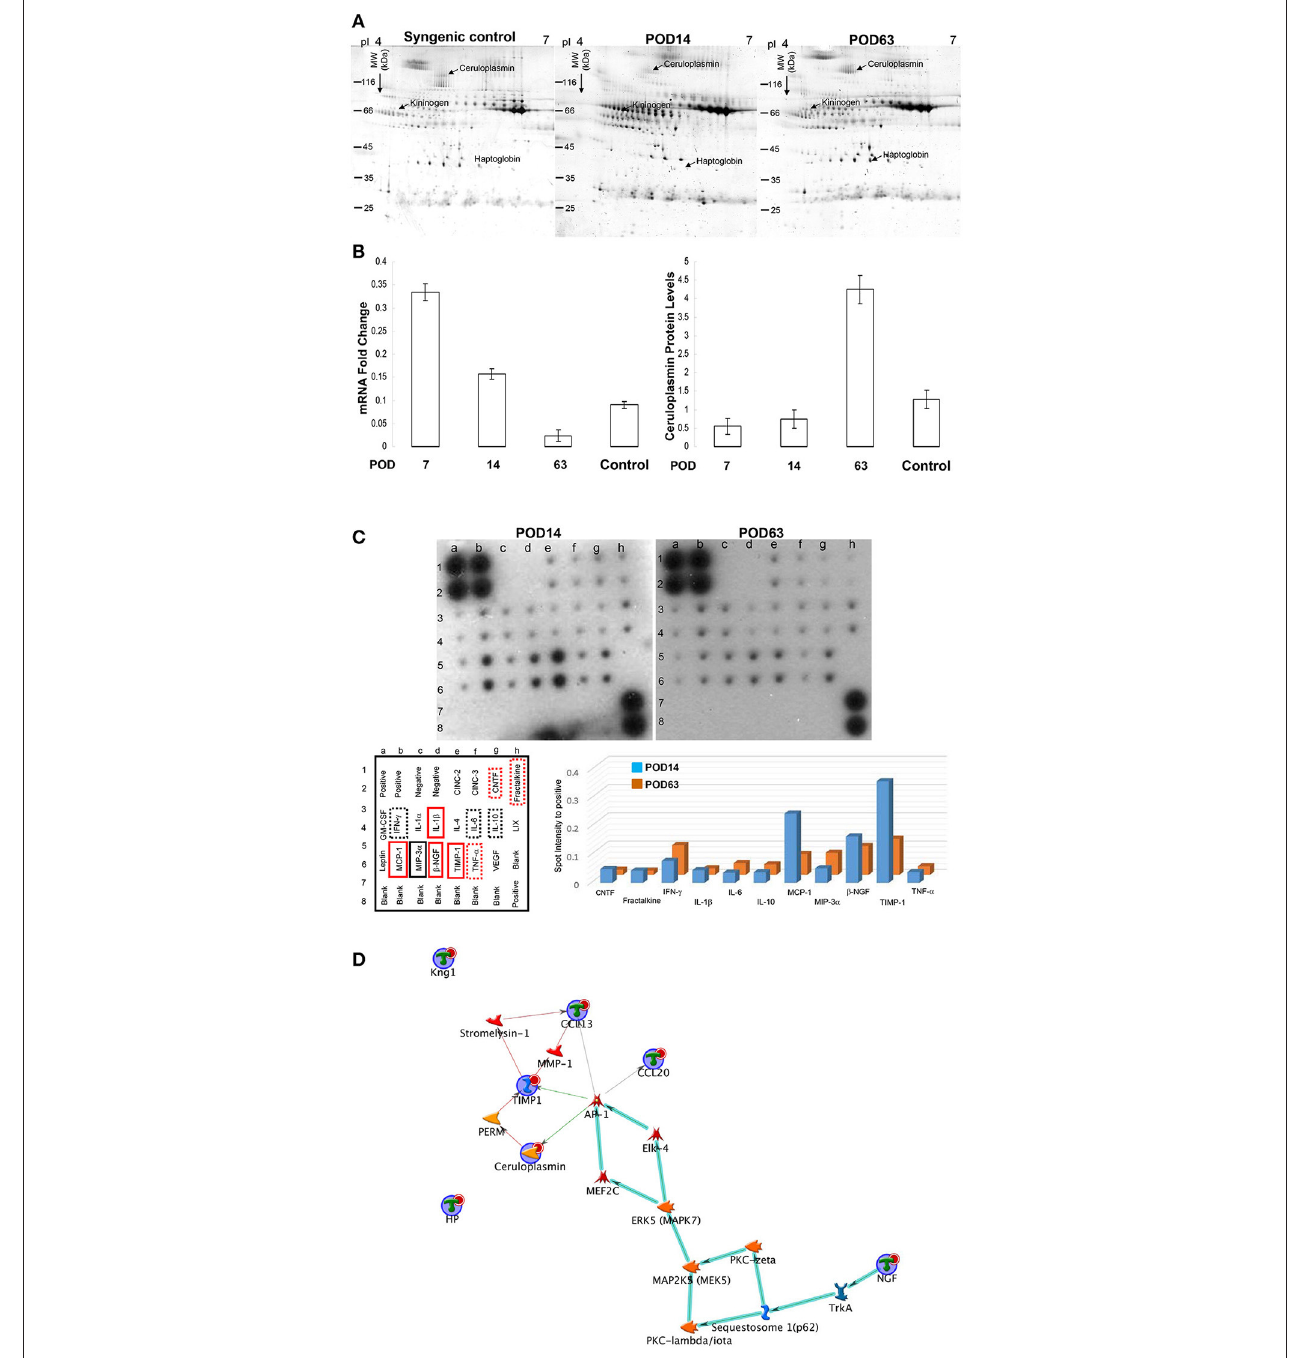
FIGURE 2 | (A) Typical 2-DE protein profiles of rat serum samples. The protein volume was determined, and their intensities were quantified by sliver-stained 2-DE (Nonlinear Progenesis software). (B) The mRNA and protein levels of ceruloplasmin were normalized and the results represent the mean ± SD of three independent experiments on POD7, 14, 63 and control sample (syngenic control). (C) Cytokine levels were assessed by protein array on POD14 and POD63. The internal positive and negative controls were compared among array exposures. Cytokine/chemokine levels were normalized with respect to positive controls on the array membrane. The red solid line rectangle indicating the significantly higher values of cytokines in the rejection group compared to the tolerance sample whereas the black solid line rectangle showed significantly reduced level of cytokines on POD14 compared to that on POD63. The dotted line rectangles indicating the signals were slightly different with no statistical significance. The quantitative results indicating the different values were demonstrated as a bar chart. (D) Network analyses of differentially expressed proteins were applied with MetaCore software. Nodes represent proteins and lines between the nodes indicate direct protein–protein interactions. The various proteins on this map are indicated by different symbols demonstrating the functional class of the proteins. The biologic pathways in this network are mainly involved in immune regulation.